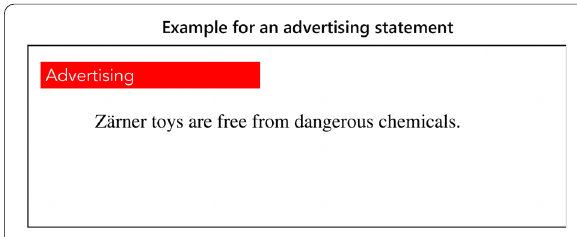
Fig. 1 Example for an advertising statement. Note : The statement has been translated to English; the version used in the experiment was in German